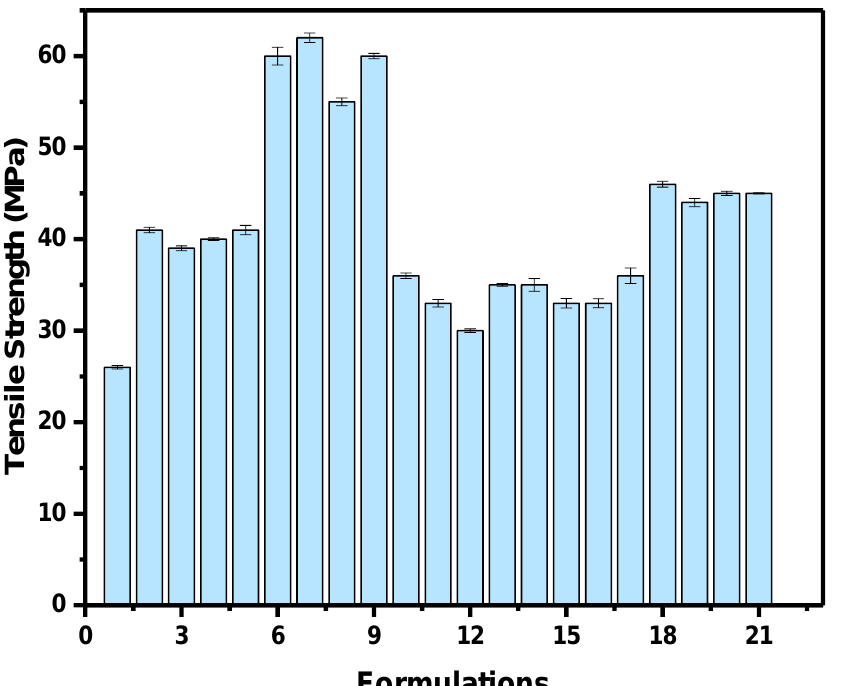
Figure 4. Tensile strength (MPa) of the HDPE/filler composites.